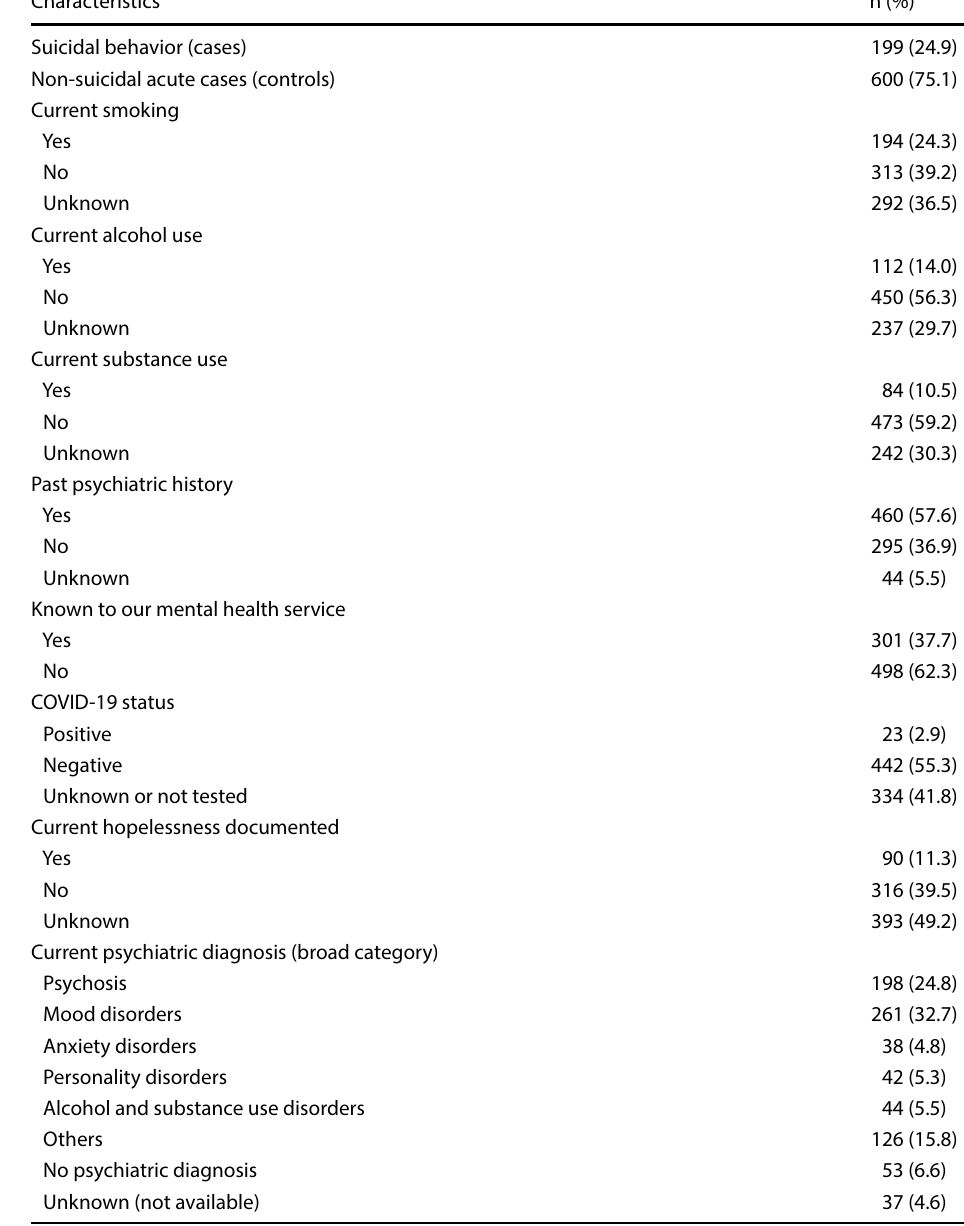
Table 2 Clinical characteristics of the study sample (N = 799)